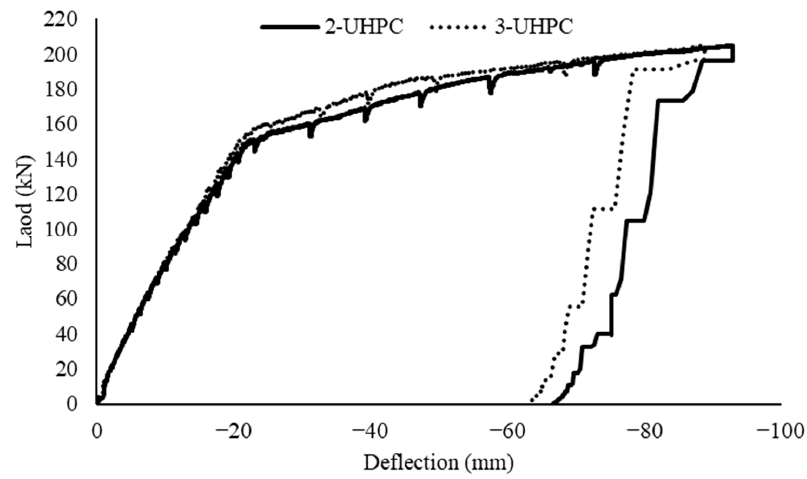
Figure 13. Load vs. deflection plot for connected girder specimens repaired with UHPC.